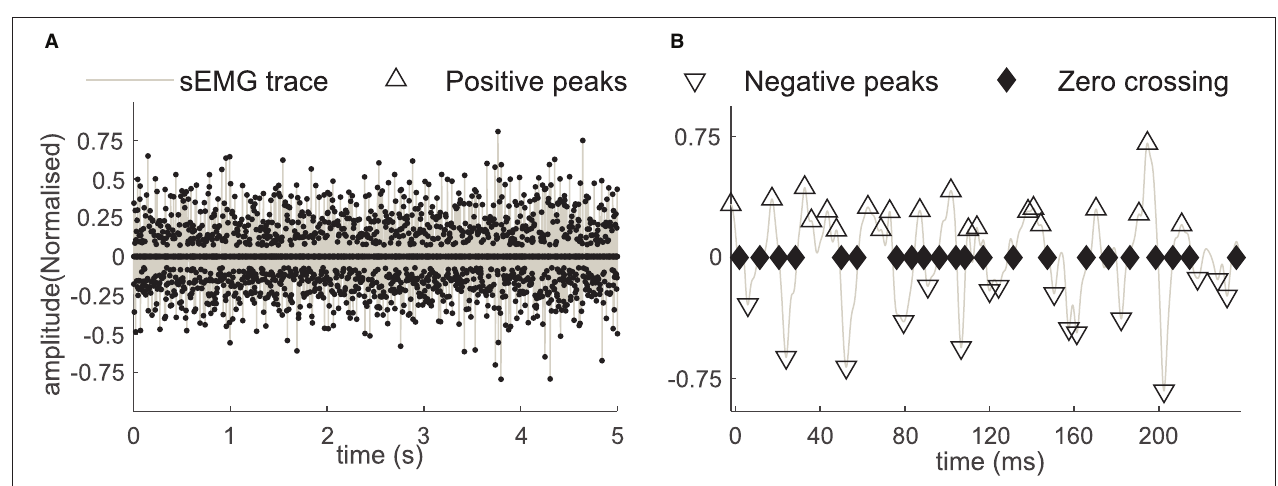
FIGURE 3 | (A) The positive and the negative sEMG peaks and the ZC instances in the sEMG during the 5-second window. (B) The sEMG and the peaks with a magnified time scale, the positive peaks (marked with 1 ), the negative peaks (marked with ∇ ), and the zero crossings (marked with the (cid:7) ) in affected side recording of the subject